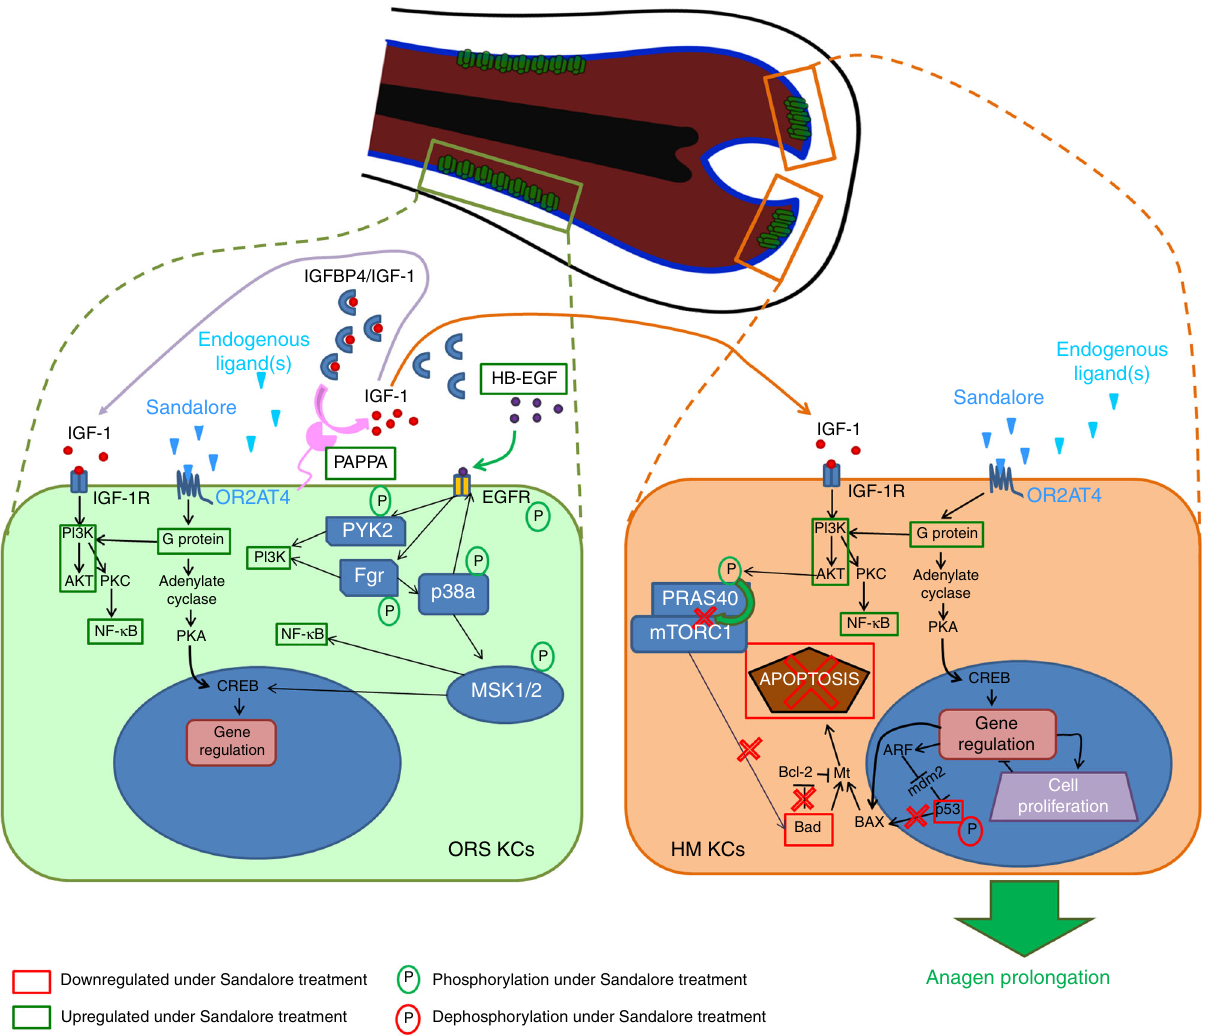
Fig. 8 Proposed mechanism of action of OR2AT4 activation by Sandalore ® and (unknown) endogenous ligand(s) in human hair follicle epithelium. The activation of OR2AT4 at the cell surface of outer root sheath keratinocytes (ORS KCs; location: see green cells in the central HF cartoon) by endogenous ligands and/or Sandalore ® upregulates the expression of genes and kinases involved in programmed cell death, thus preventing intrafollicular apoptosis (e.g., by phosphorylation of PRAS40 preventing its interaction with mTOR1, upregulation of NF- κ B pathway) or downregulates key players in the apoptotic machinery (e.g., dephosphorylation of p53, downregulation of Bad). In parallel, OR2AT4 activation by exogenous (Sandalore ® ) or endogenous ligands (e.g., metabolites of the HF microbiome) induces the upregulation of PAPPA that cleave the IGFBP4/IGF1 complex to release IGF-1 (pink arrows). The released IGF-1 triggers the activation of IGF-1R on the same cell (autocrine signaling, purple arrow) or on hair matrix keratinocytes (HM KCs; orange “ cell ” ) (paracrine signaling, orange arrow). The activation of IGF-Rs on HM keratinocytes then induces signaling cascades (e.g., PI3K/AKT and/or p38a/ERK1/2/ MSK1/2) that activate different transcription factors and particularly CREB, which results in an anti-apoptotic effect and prolonged anagen phase in